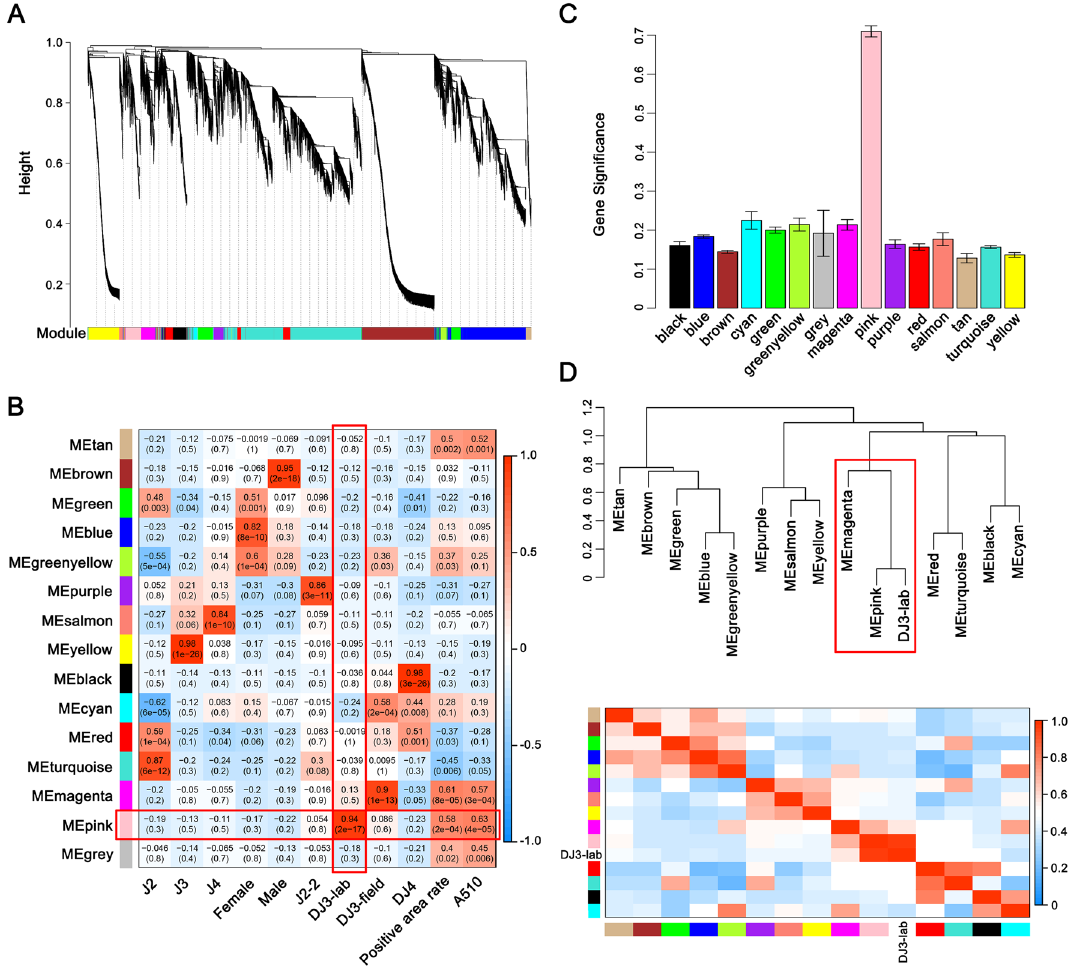
Figure 2. Weighted gene coexpression analysis (WGCNA) revealed the module highly related to Bursaphlenchus xylophilus DJ3-lab. ( A ) Clustering dendrograms of genes, with dissimilarity based on the topological overlap, together with assigned module colors. ( B ) Module-trait associations. Each row corresponds to an ME, and each column corresponds to a trait. Each cell contains the corresponding correlation and p- value. The table is color-coded by correlation according to the color legend. ( C ) Bar plot of module significance defined as the mean gene significance across all genes in the module to DJ3-lab. ( D ) The hierarchical clustering dendrogram and the heatmap of correlated MEs and